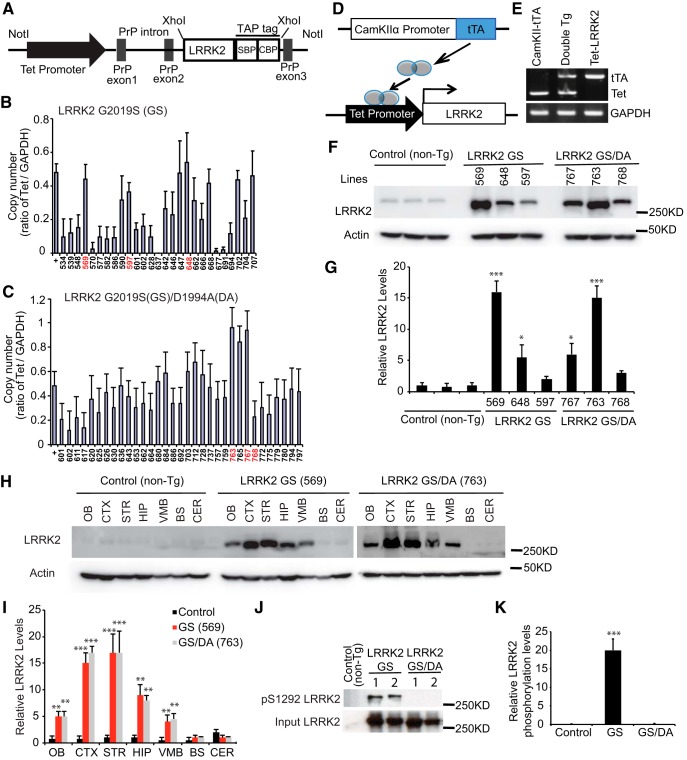
Generation of TET-inducible conditional LRRK2 transgenic mice. A, Schematic diagram of the TetP-LRRK2-TAP construct. B, Relative transgene copy number determined by semiquantitative PCR performed on genomic DNA expressed in arbitrary units as the ratio of the TetP-LRRK2-G2019S (GS) transgene to GAPDH for each founder mouse. C, Relative transgene copy number determined by semiquantitative PCR performed on genomic DNA expressed in arbitrary units as the ratio of the TetP-LRRK2-GS2019S/D1994A (GS/DA) transgene to GAPDH for each founder mouse. D, Schematic diagram of the generation of LRRK2-inducible transgenic mice using the “tet-off” system. E, Representative genotyping PCR for TetP-LRRK2 and CamKIIα-tTA using genomic DNA. GAPDH PCR was used as an internal control. F, Western blot analysis of LRRK2 expression from LRRK2 transgenic mouse brain. Each number represents a single LRRK2 transgenic founder line: 569, 648 and 597 of LRRK2-GS, 767, 763, and 768 LRRK2-GS/DA transgenic mice. G, Quantification of LRRK2 expression in mouse brains normalized to β-actin, n = 3. Differences between transgenic and control groups were assessed by unpaired, two-tailed Student’s t test. Quantified data are expressed as the mean ± SEM. *p < 0.05, ***p < 0.001. H, Representative Western blots of LRRK2 distribution in brain subregions from control and LRRK2-GS (line 569) and LRRK2-GS/DA (line 763) transgenic mice (OB; CTX; STR; HIP; VMB; BS; CER). I, Quantification of LRRK2 distribution in mouse brains normalized to β-actin, n = 3. J, Western blot analysis of total protein from mouse brains of control, LRRK2 GS, and LRRK2 GS/DA by anti-LRRK2 and LRRK2 phosphor S1292 antibodies. K, Quantification of phosphor Ser1292 LRRK2 levels in mouse brains normalized to total LRRK2 protein level, n = 3. Quantified data are expressed as the mean ± SEM: *p < 0.05, **p < 0.01, ***p < 0.001, Differences between transgenic and control groups were assessed by two-way ANOVA. There was a nonsignificant difference between LRRK2 GS and LRRK2 GS/DA groups.